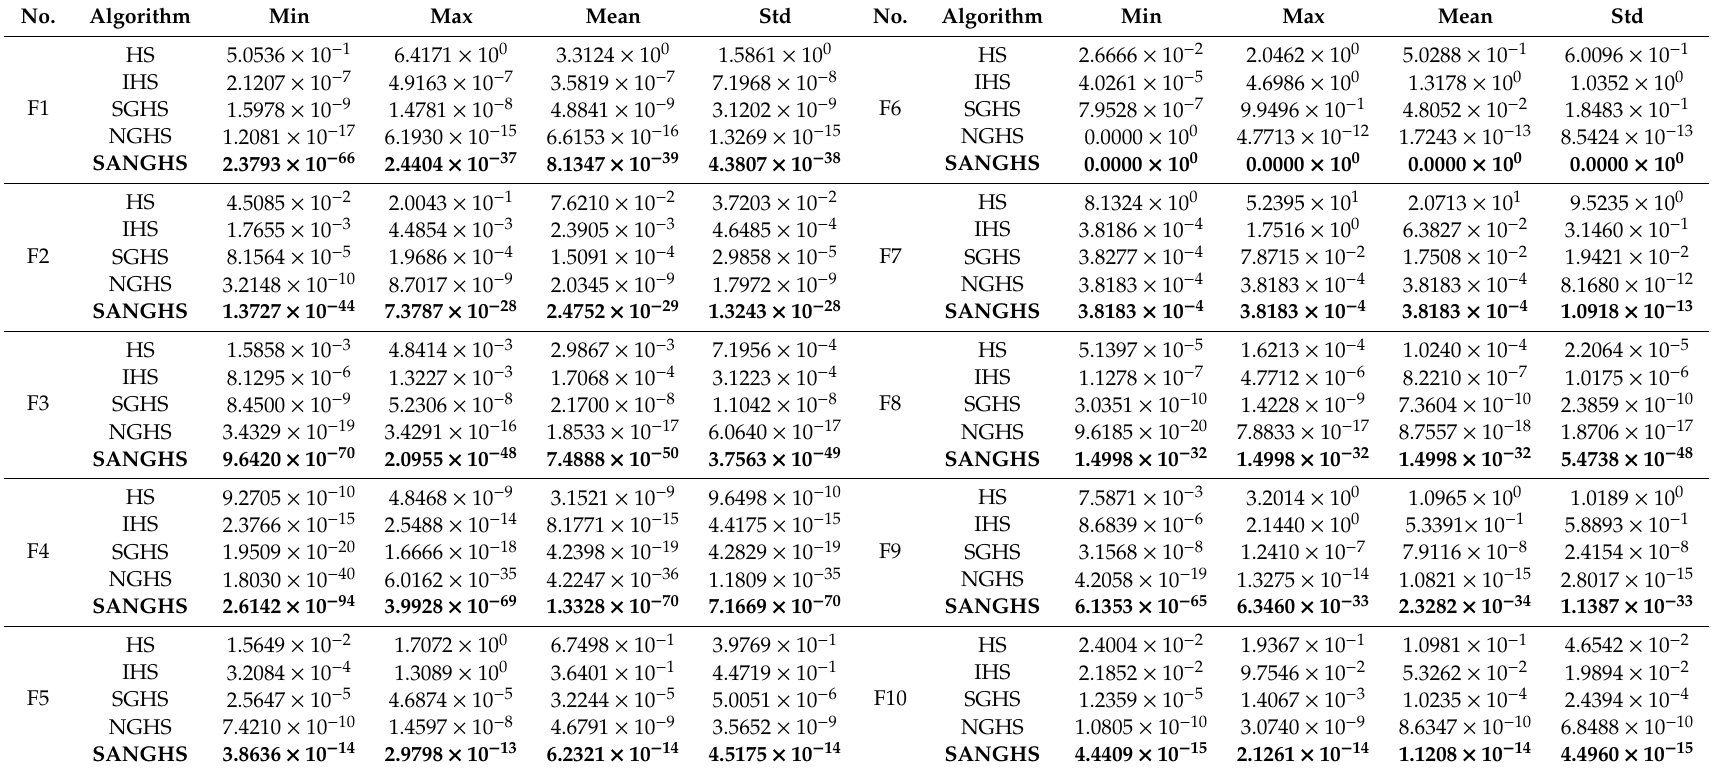
Table 3. Experimental results of five algorithms for 10 problems with D =